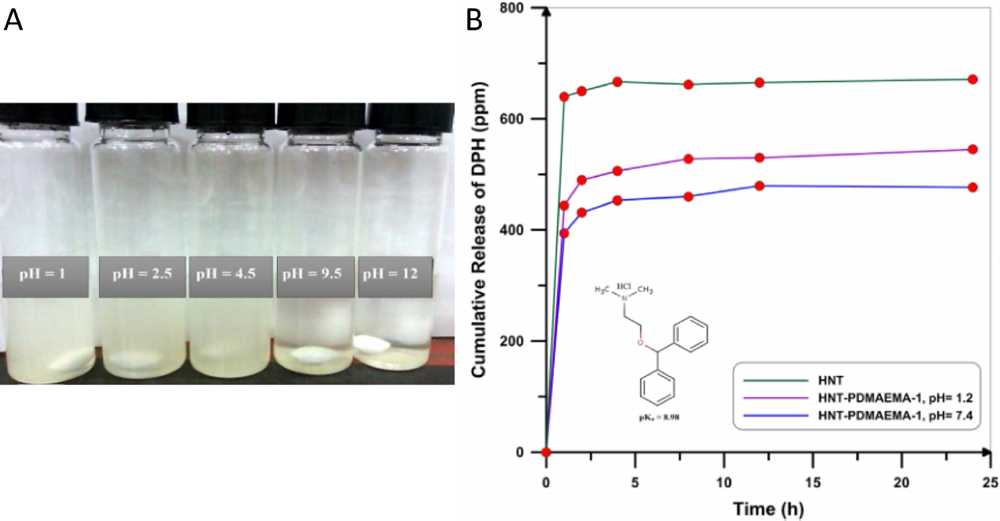
Figure 10: Sensitivity of HNT-PDMAEMA aqueous solutions with concentration of about 0.2 mg/mL to pH just 2 h after sonication (A), cumu- lative release of DPH from HNT and HNT-PDMAEMA-1 at two different pH values (B) demonstrated by Hemmatpour et al. [119]